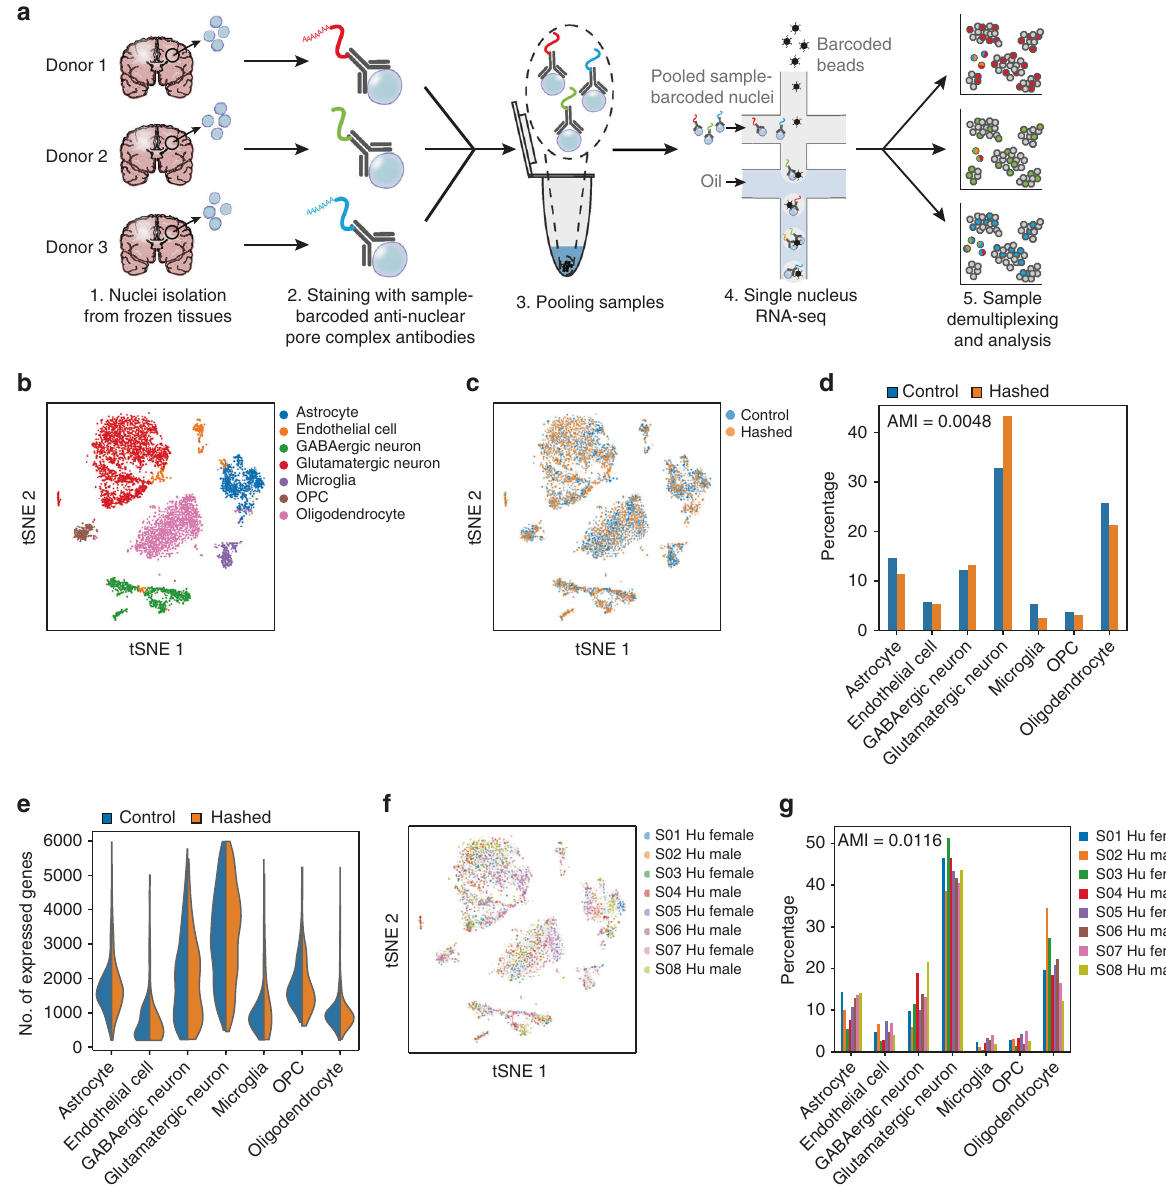
Fig. 1 Nuclei multiplexing using DNA-barcoded antibodies targeting the nuclear pore complex. a Experimental work fl ow. Nuclei are isolated from frozen tissues and stained with DNA-barcoded antibodies targeting the nuclear pore complex (MAb414, Biolegend). The DNA barcode encodes a unique sequence representing each tissue sample, enabling sequence-based identi fi cation of each nucleus after pooling and pro fi ling the different samples. b – e Hashed and non- hashed samples of the human cortex from eight postmortem donors yield comparable results. b t -stochastic neighborhood embedding (tSNE) of single-nucleus pro fi les (dots) colored by cell type. c tSNE as in b colored by type of protocol. Non-hashed control sample (blue) and hashed sample (orange) show similar patterns. d Cell-type frequencies observed for hashed (orange) and non-hashed control (blue) samples. The adjusted mutual information (AMI) is shown at the top left. e Distributions of the number of expressed genes ( y- axis, left) in each cell type ( x- axis) in b , for nuclei from hashed (orange) and non-hashed control (blue) samples. f , g Hashed single nuclei from all donors are similarly represented across cell-type clusters. f tSNE as in b colored by donor. g Observed frequencies ( y- axis) of each cell type ( x- axis) per donor (color). The adjusted mutual information (AMI) is shown at the top left. Please follow the Supplementary Note in the Supplementary Information to reproduce this fi gure. Availability of source data is indicated in the Data Availability